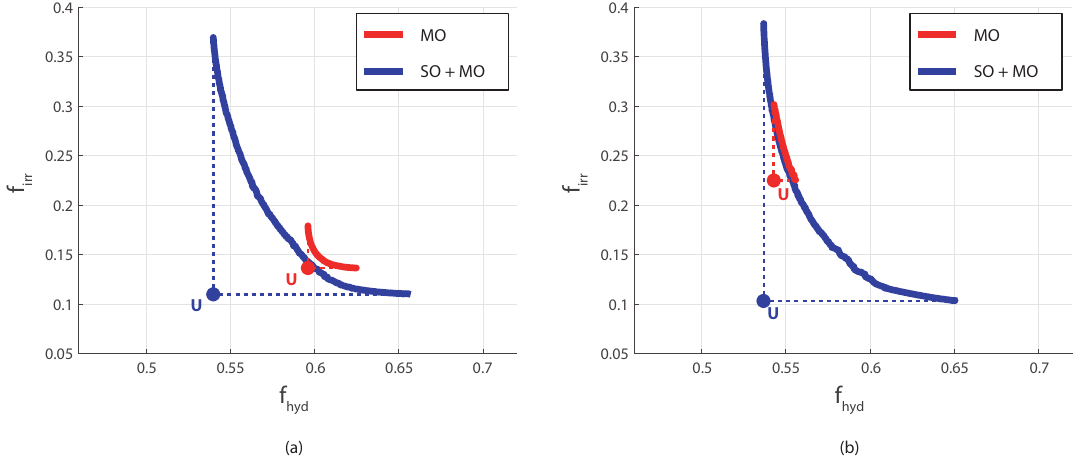
Figure 10. Pareto fronts computed with the MO and SO+MO methods solving the optimal management of the Lower Nile River basin. Two sample scenarios are represented in panels ( a , b